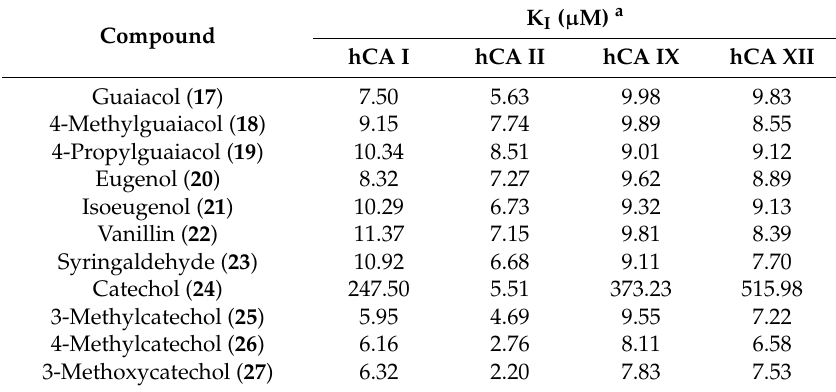
Table 2. Inhibition constants of certain phenolic compounds derived from guaiacol and catechol against four human carbonic anhydrase isoenzymes (hCA I, II, IX and XII) using an esterase bioassay